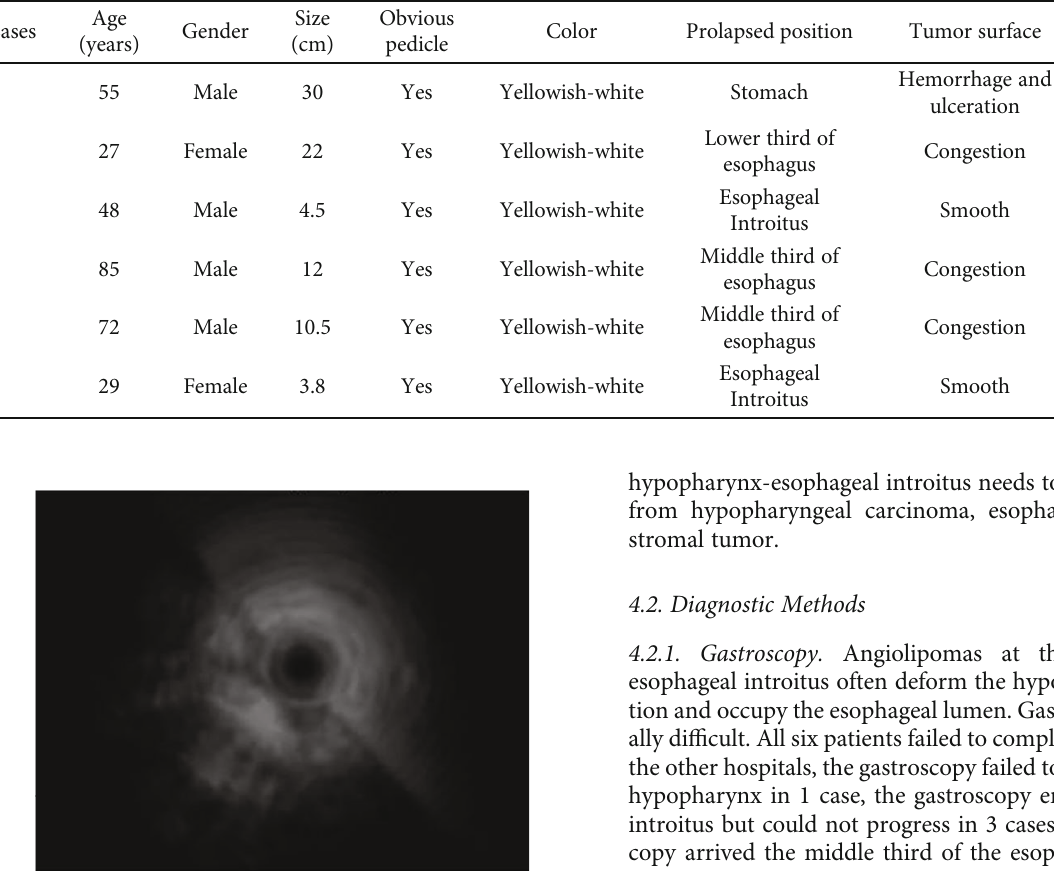
Figure 4: EUS showed both a good mucosal layer, an irregular submucosal, muscle-like area, and slightly hyperechoic